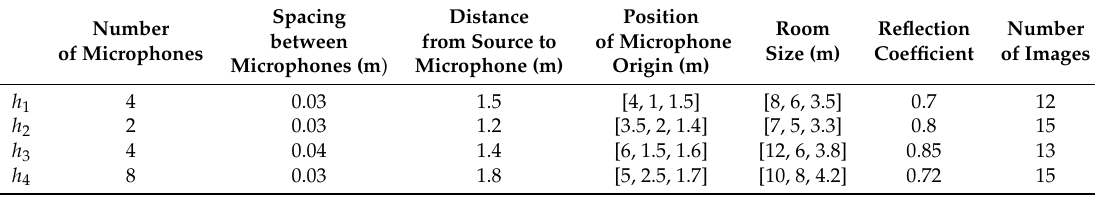
Table 1. Speech database (DB) simulated with the image method